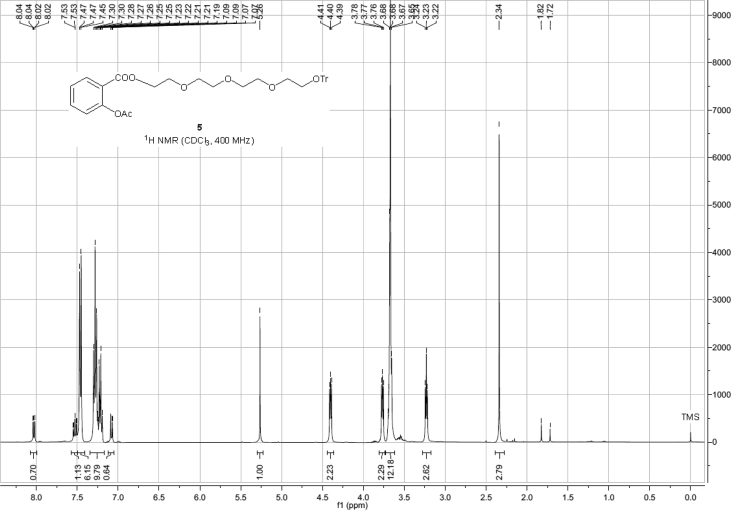
1H NMR spectra of compound 5.